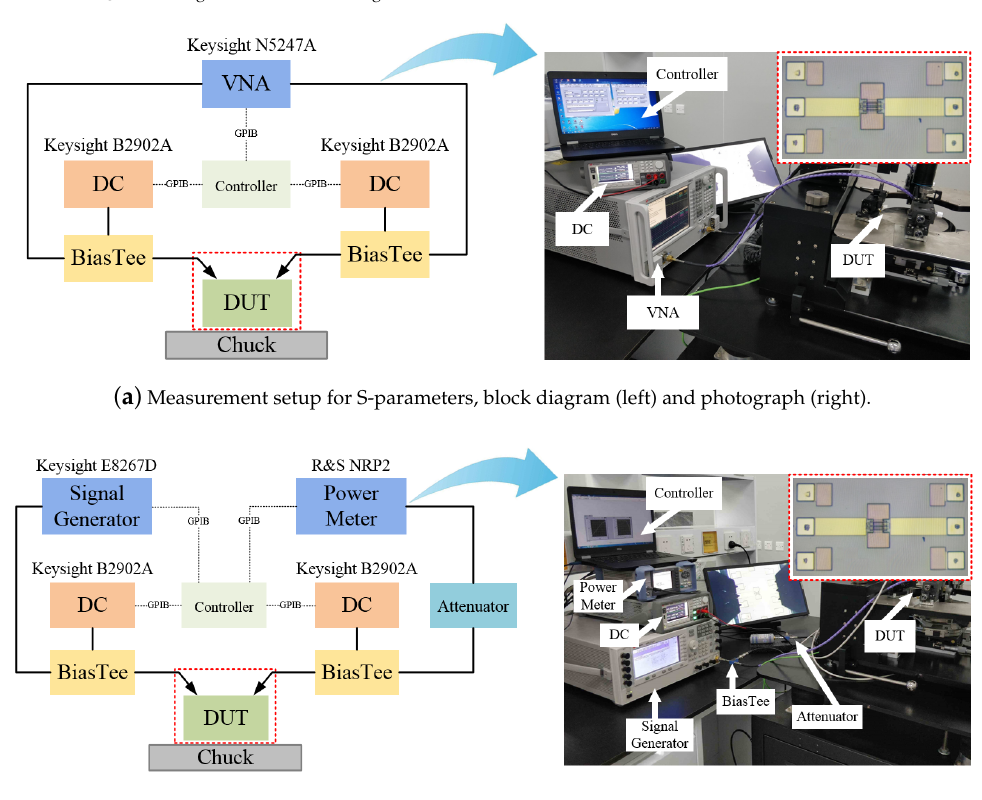
Figure 3. Measurement setup to perform RF measurements under different bias conditions. Block diagram and photograph for S-parameters ( a ) and power ( b ); the inset is the photograph of the